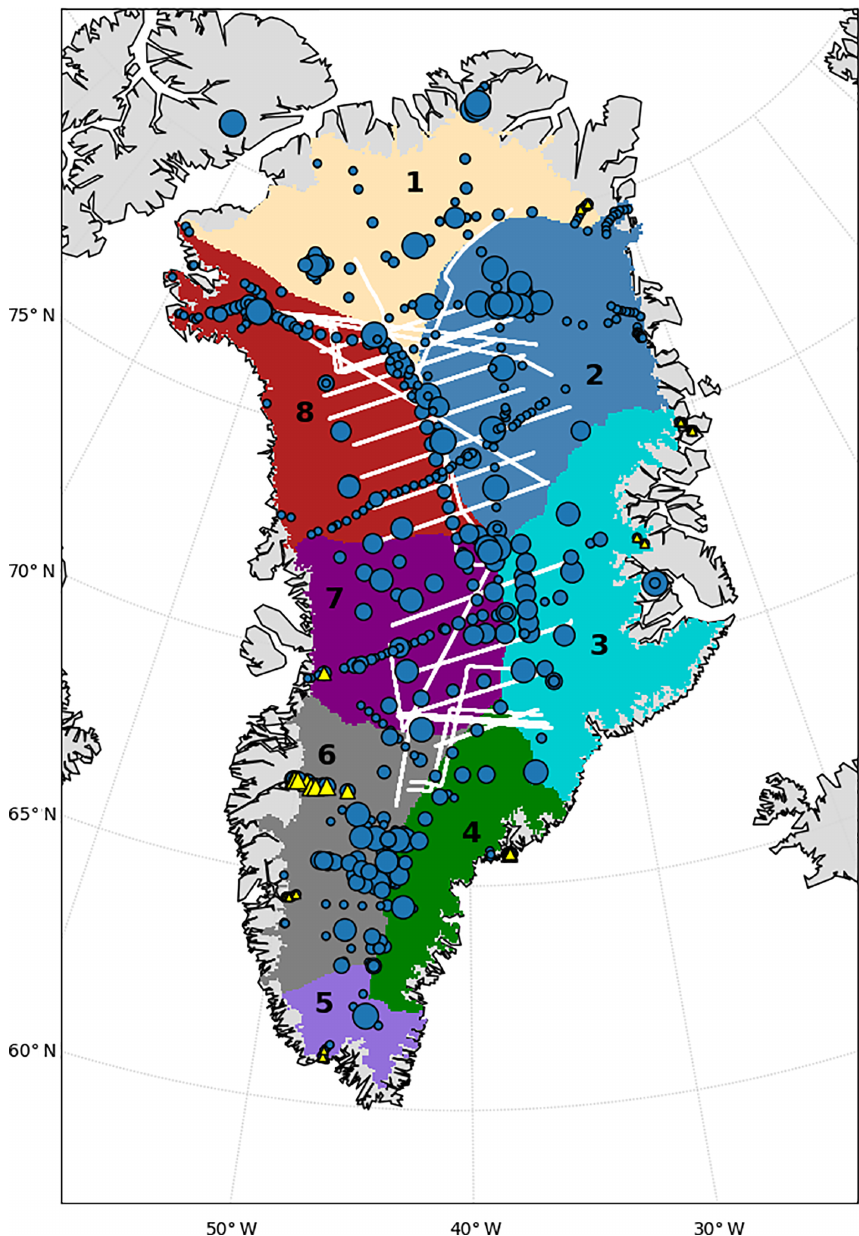
Figure 1. Greenland ice sheet drainage basin delineations (colored and numbered regions) as in Zwally et al. (2012), the location and temporal extent of the pit/core locations (filled circles and triangles), and the altimetry transects (white lines) used in LIVVkit SMB analyses. The basin numbers follow Zwally’s designation and the colors correspond to those used in histograms and scatter plots throughout. Pit/core data points are sized by the length of their temporal record, with larger points indicating annual estimates were taken from a greater number of yearly SMB